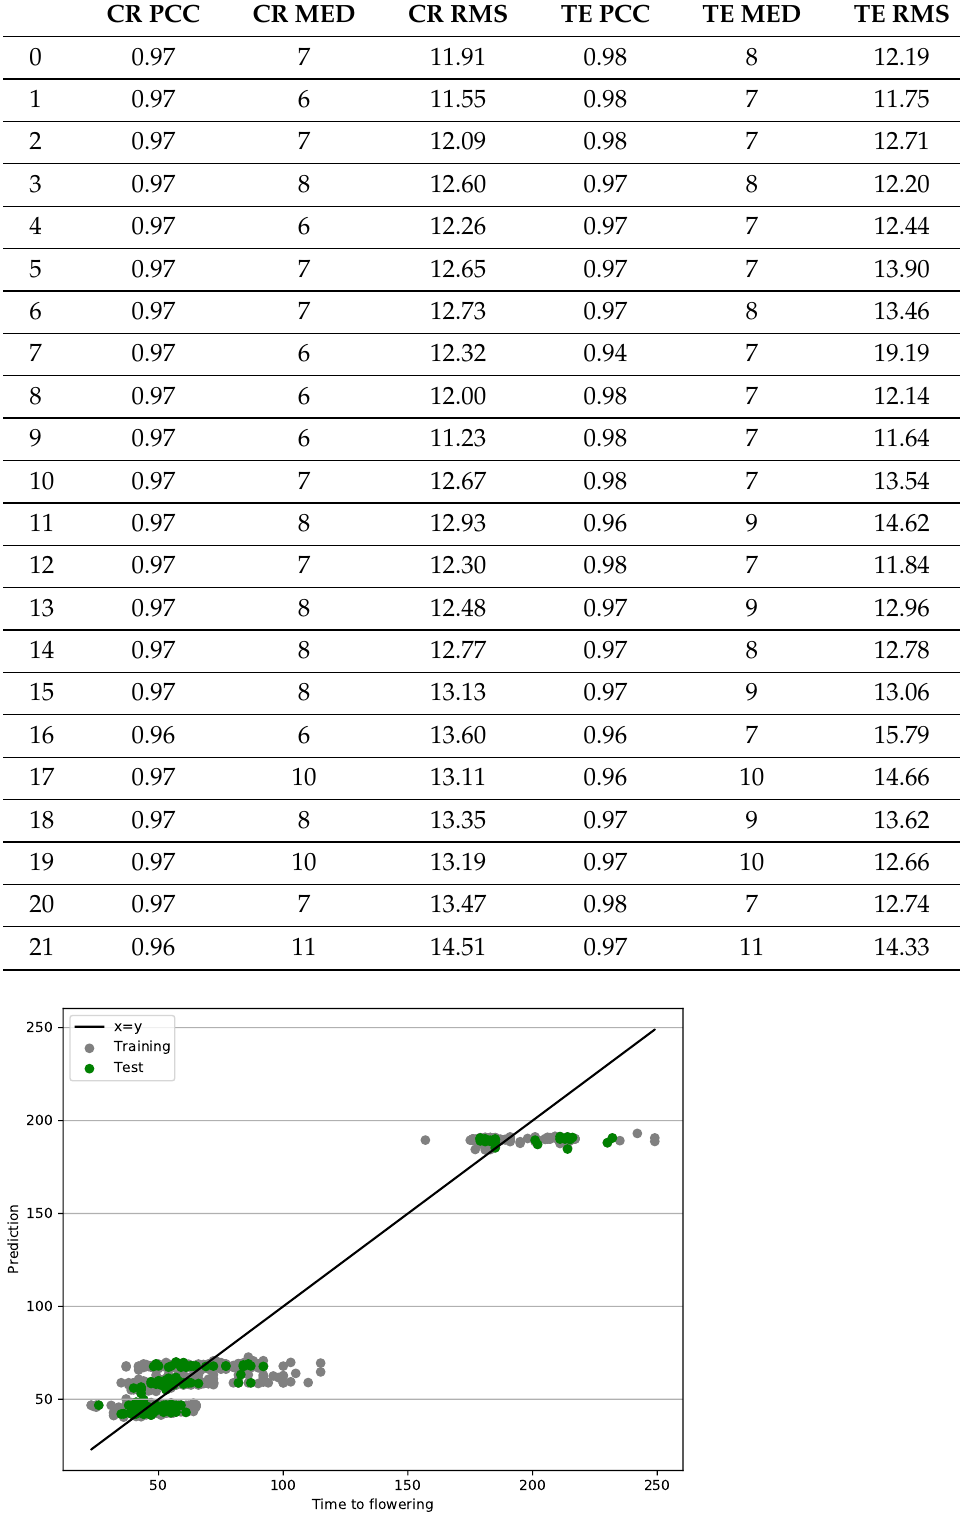
Figure 5. Comparison of the model solutions with data of the cross-validation dataset and the model predictions with the data of the control dataset. The slope of diagonal line is